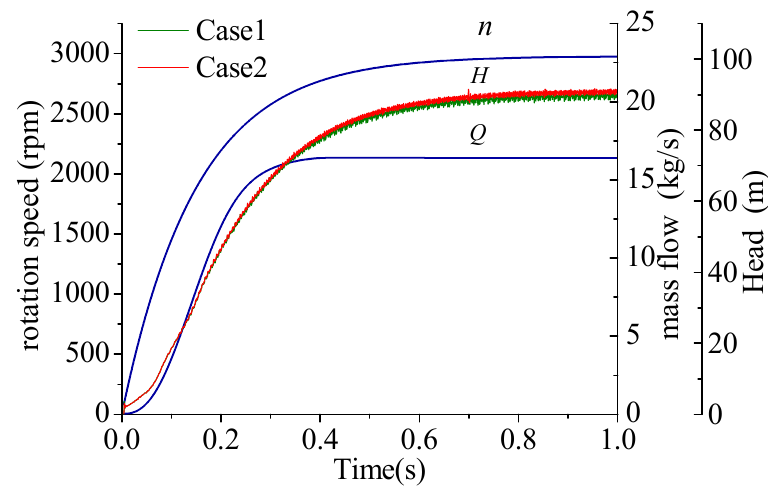
Figure 8. Curves of the speed of rotation, mass flow rate, and total head vs. time. Figure 9 plots the rates of change in the speed of rotation, mass flow rate, and total head. The time derivative of the speed of rotation declines rapidly to a stable value during the startup process. The rate of change in the flow of mass increases to its maximum at 0.15 s and then fell gradually but remains positive from 0.15 s to 0.4 s, indicating that it had slowed down. At 0.4 s, the rate of flow reaches a steady state and remains stable during the remaining time. At t < 0.1 s, the rate of change in the total head remains almost constant and variations in the head are not evident; during 0.1–0.4 s, the curve exhibited prominent fluctuations that become more intense with the acceleration of the impeller; when t is above 0.4 s, the amplitude of fluctuations remains stable. This analysis shows that the transient boundary conditions have a significant impact on the external characteristics of the pump during the startup period.